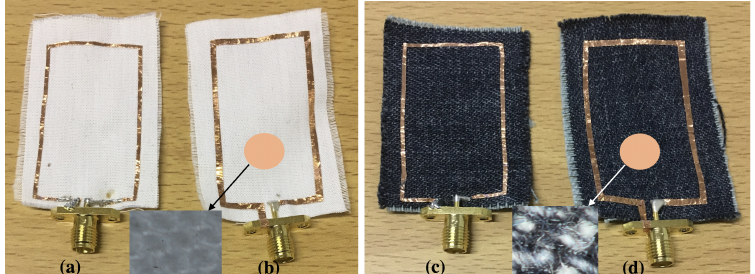
Figure 4. Fabricated wearable loop antenna on various textile fabrics: ( a ) in cotton with width = 1 mm; ( b ) in cotton with width of 2 mm; ( c ) in jeans with width = 1 mm; and ( d ) in jeans with width of 2 mm. Insets provide a zoomed-in microscopic view of fabrics.